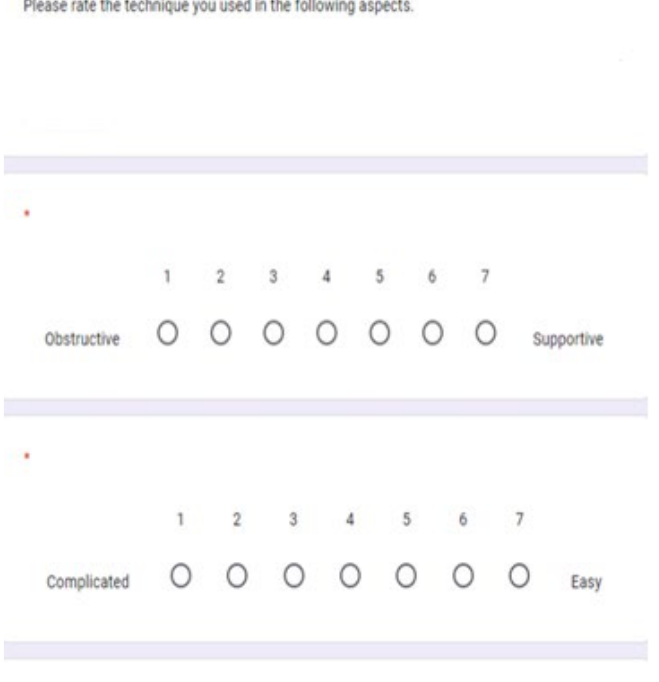
Figure 8. Sample of the User Experience Questionnaire.